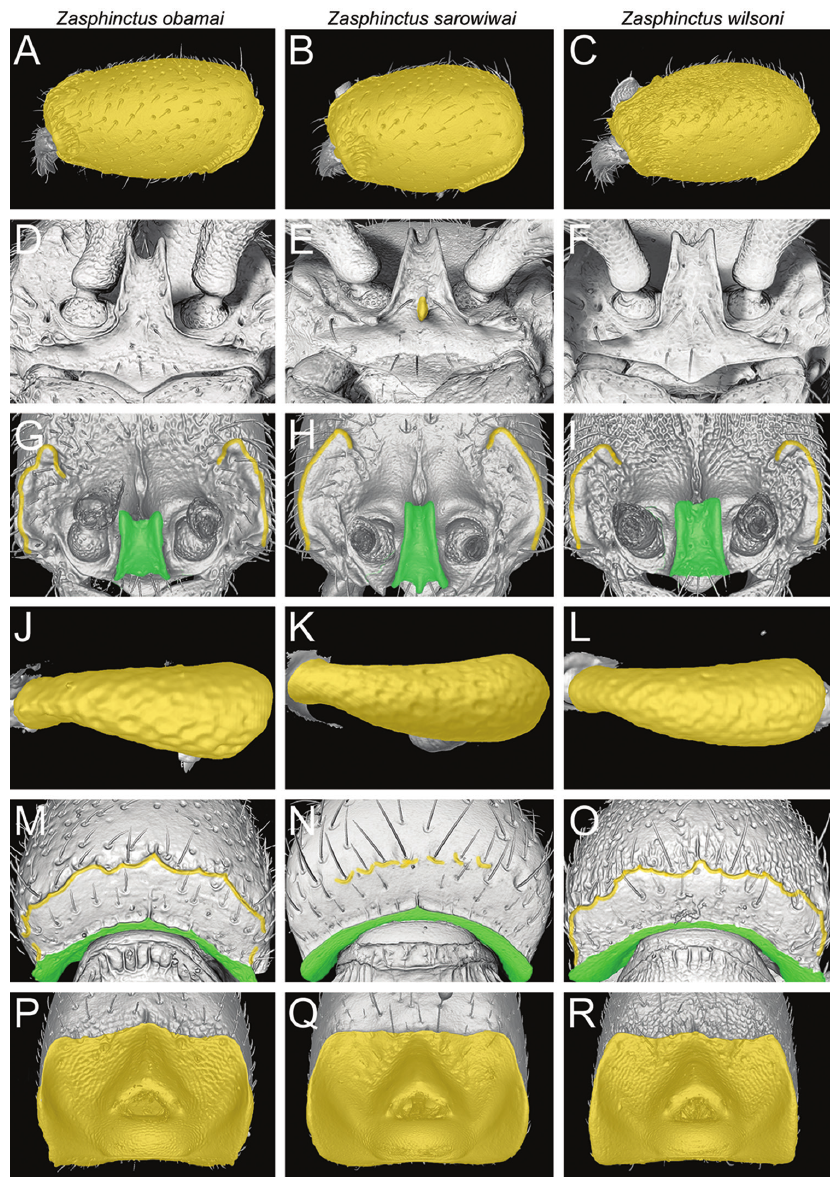
Figure 4. Illustrated diagnostic character matrix based on micro-CT images used for species delimita- tions ( Z. obamai = left column, Z. sarowiwai = middle column, Z. wilsoni = right column). A, B, C Ce- phalic capsule in profile (virtually dissected) D, E, F Clypeus and torulo-posttorular complex in anterior view G, H, I Anterior head (antennae virtually removed) showing parafrontal ridges (orange) and torulo- posttorular complex (green) J, K, L Antennal scape in dorsal view (virtually dissected) M, N, O Head in posterodorsal view showing vertexal margin (orange), posterior face, and occipital margin (green) P, Q, R Head in posterior view showing occiput and occipital foramen (virtually dissected) (ventral head facing